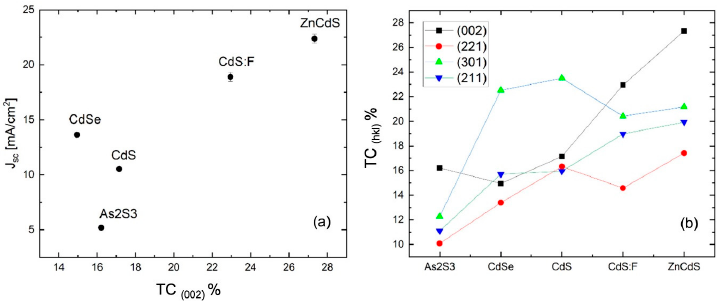
Figure 7. ( a ) Short circuit current density as a function of the TC (002) for different window layers; ( b ) TCs behavior of the main diffraction peaks for different window layers.